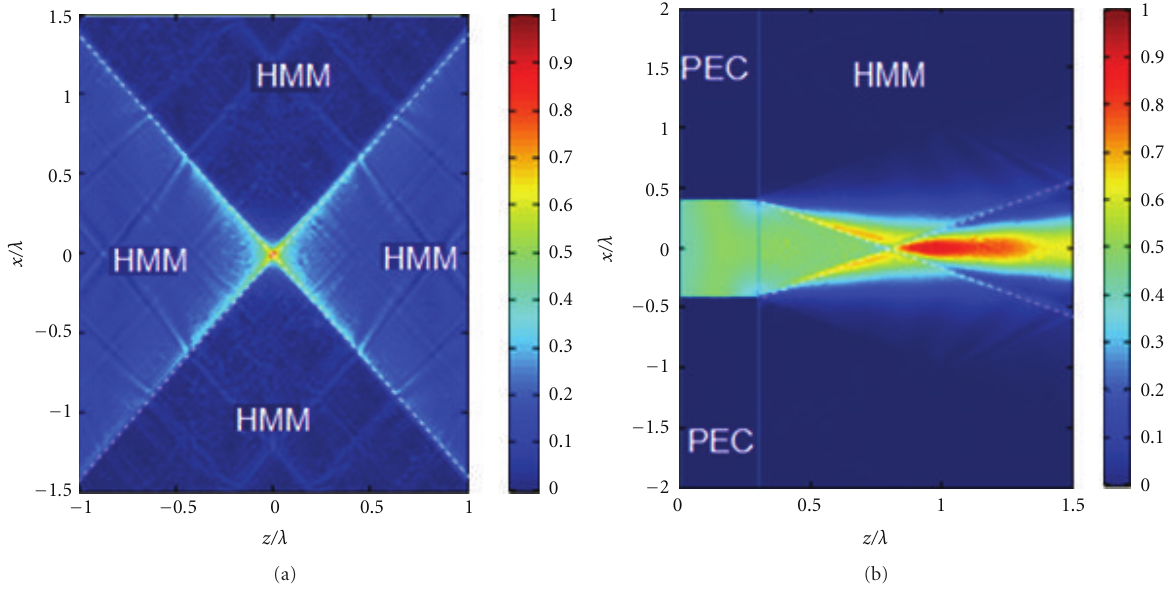
Figure 2: (a) Radiation of a point source inside a HMM ( ε z = − 4 and ε x = 1). (b) Light propagation through a sharp edge aperture in HMM and the cross of preferred directions resulting in